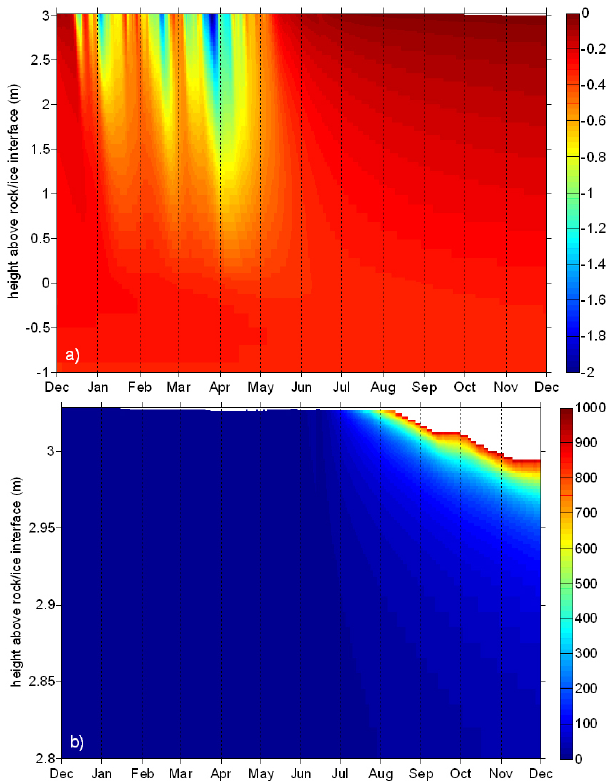
Fig. 8. Time-depth development of ice and rock temperatures within the model domain (upper panel) and liquid water content (kgm − 3 ) in the top 20cm (lower